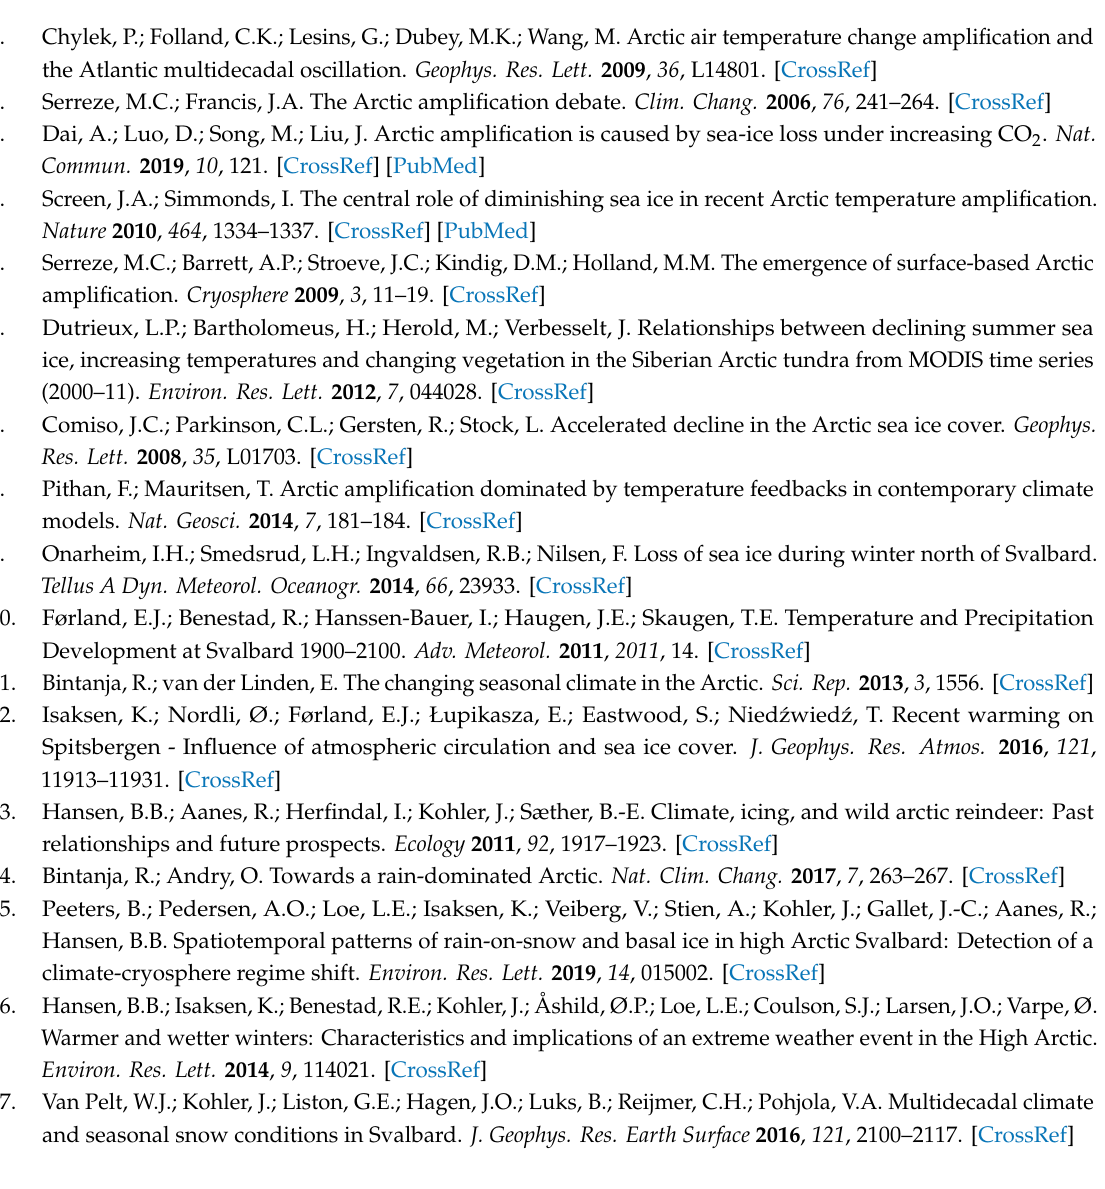
Figure A5. As for Figure A3 but for FSFD variations averaged over the whole of Svalbard and TI-SIC for Northeast Svalbard.